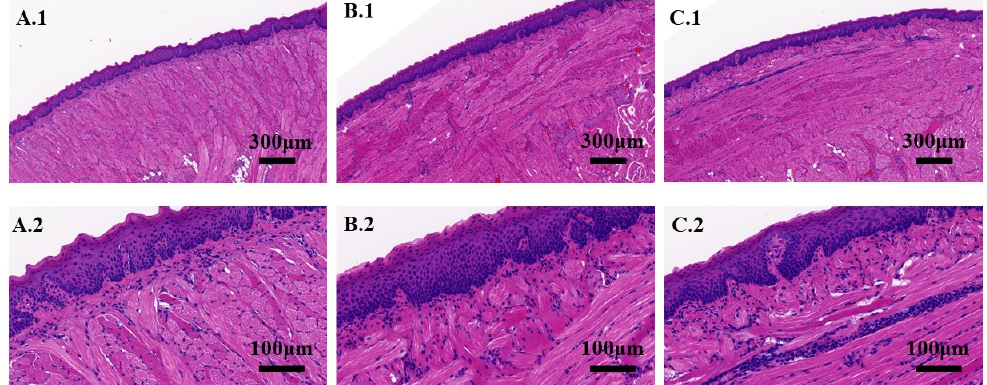
Figure 9. Histological sections of sublingual mucosa after buccal administration of ( A.1 , A.2 ) saline solution, ( B.1 , B.2 ) IPC-DNVs, and ( C.1 , C.2 )